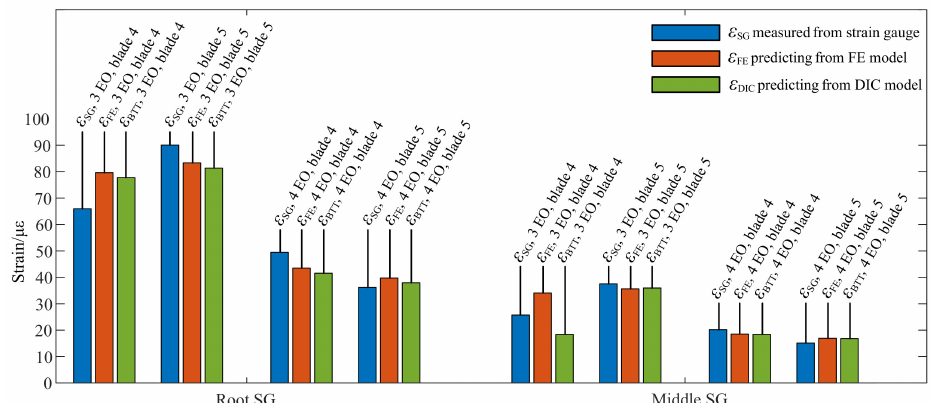
Figure 14. Comparative of measured strains and predicting strains the first order of mode frequency.